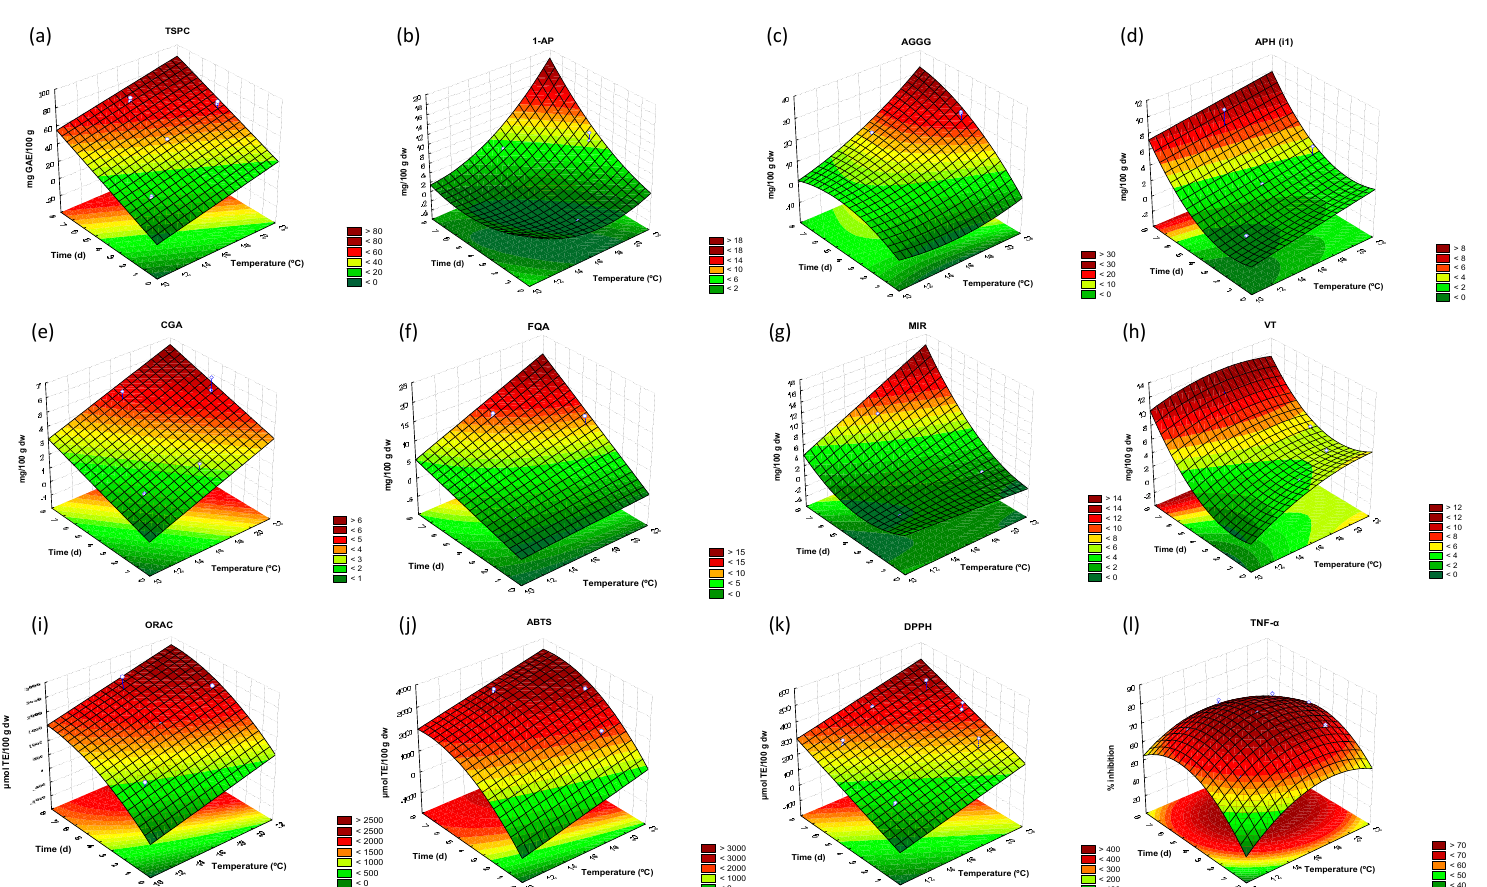
Figure 1. Response Surface 3D contour plots for combined effect of germination time and temperature on ( a ) total soluble phenolic content (TSPC), ( b ) 1-acetoxypinoresinol (1-AP), ( c ) apigenin-6- C -galactosyl-8- C -glucosyl- O -glucuropyranoside (AGGG), ( d ) apigenin-6 / 8- C -pentoside-8 / 6- C -hexoside (APH i1), ( e ) caffeic acid O -hesoxide (CAH), ( f ) feruloylquinic acid (FQA), ( g ) methyl isoorientin-2- O -rhamnoside (MIR), ( h ) vitexin (VT), ( i ) oxygen radical absorbance capacity (ORAC), ( j ) 2’-azino-bis(3-ethylbenzothiazoline-6-sulfonic acid) (ABTS); ( k ) 2,2-diphenyl-1-picryl-hydrazyl-hydrate (DPPH), ( l ) tumor necrosis factor - α inhibition (TNF- α ). Blue dots represent the data of the experimental groups of samples.